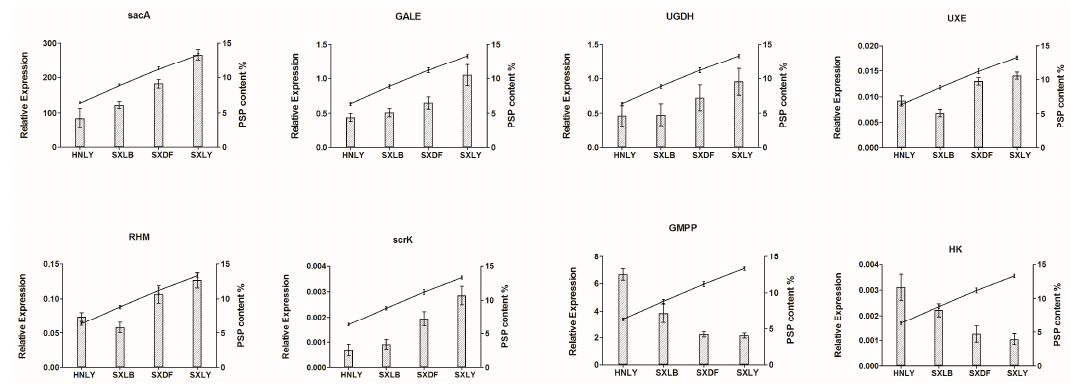
Figure 9. The expression of candidate unigenes involved in PSP biosynthesis between different germplasms. y -Axis on left side of each chart indicates the level of relative expression based on results from real-time PCR. Error bars show SD ( n = 9). y -Axis on right side of each chart indicates % PSP content.